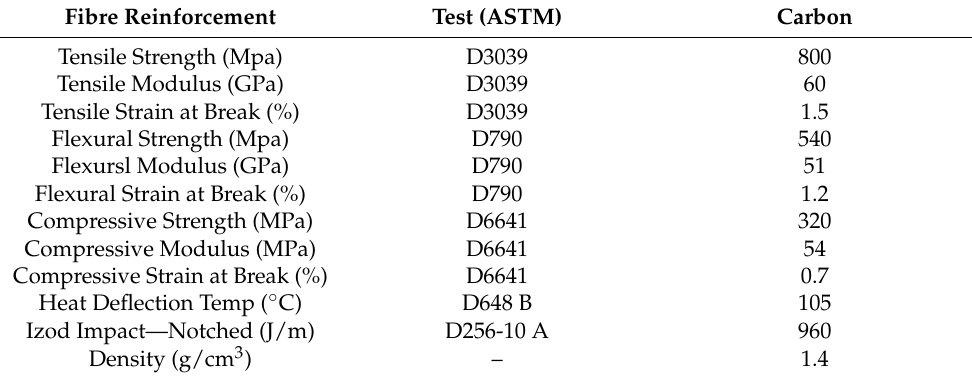
Table 2. Carbon fibre filament